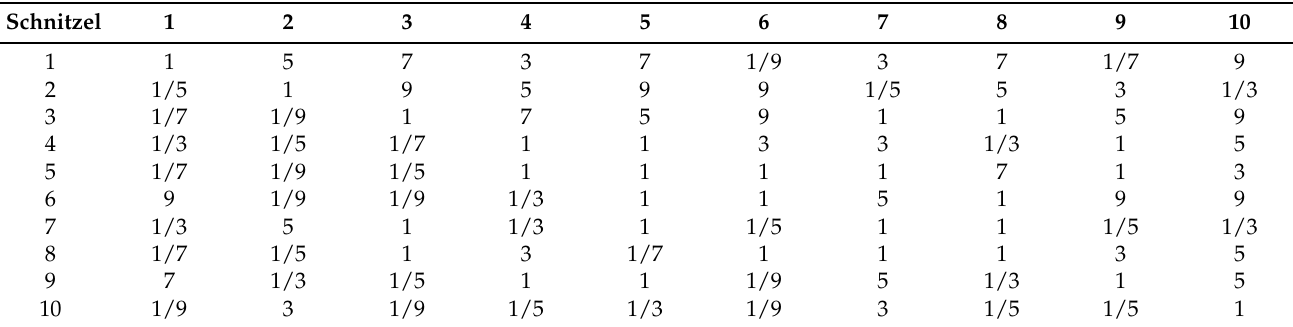
Table A10. Pairwise comparisons matrix of schnitzel.